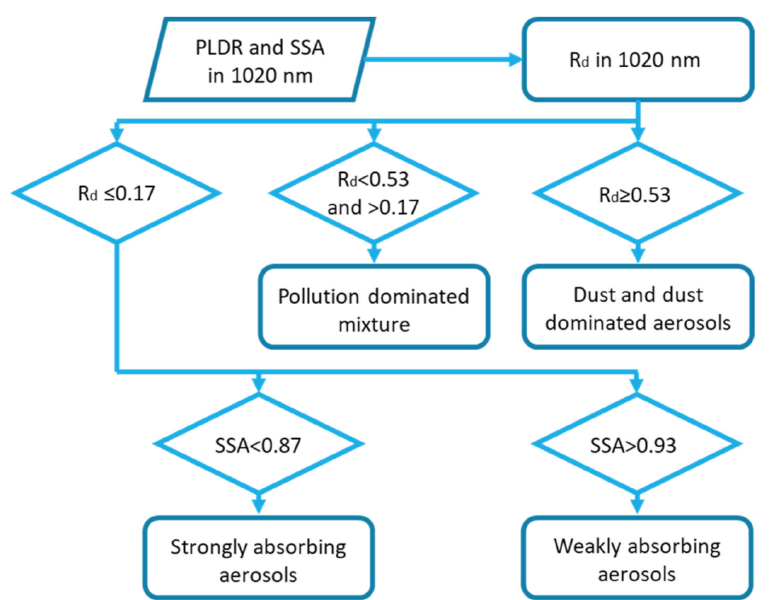
Figure 1. The flowchart of classification base on PLDR (particle linear depolarization ratio) and SSA (single scatter albedo) in 1020